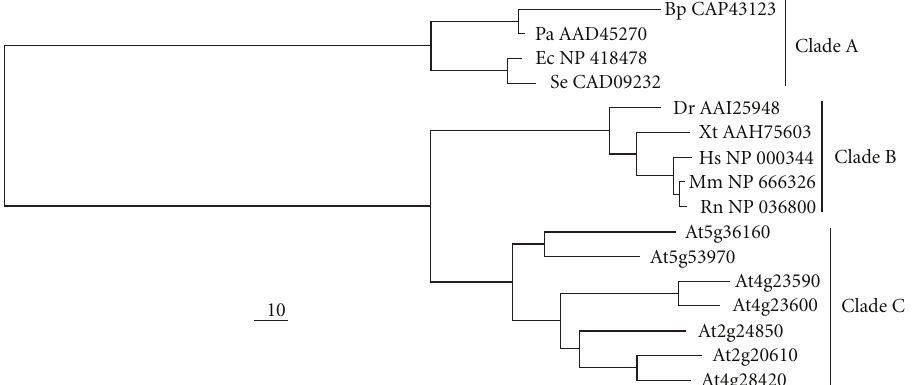
Figure 7: Phylogenetic tree depicting the evolutionary relationship between TATs from bacteria (Clade A), mammals (Clade B), and Arabidopsis (Clade C). The protein sequences were aligned using the ClustalW and the neighbor joining tree was constructed using the TREEVIEW